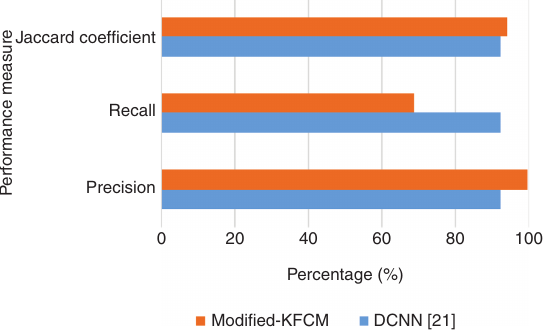
Figure 12: Graphical comparison of the proposed and existing method by means of precision, recall, and Jaccard